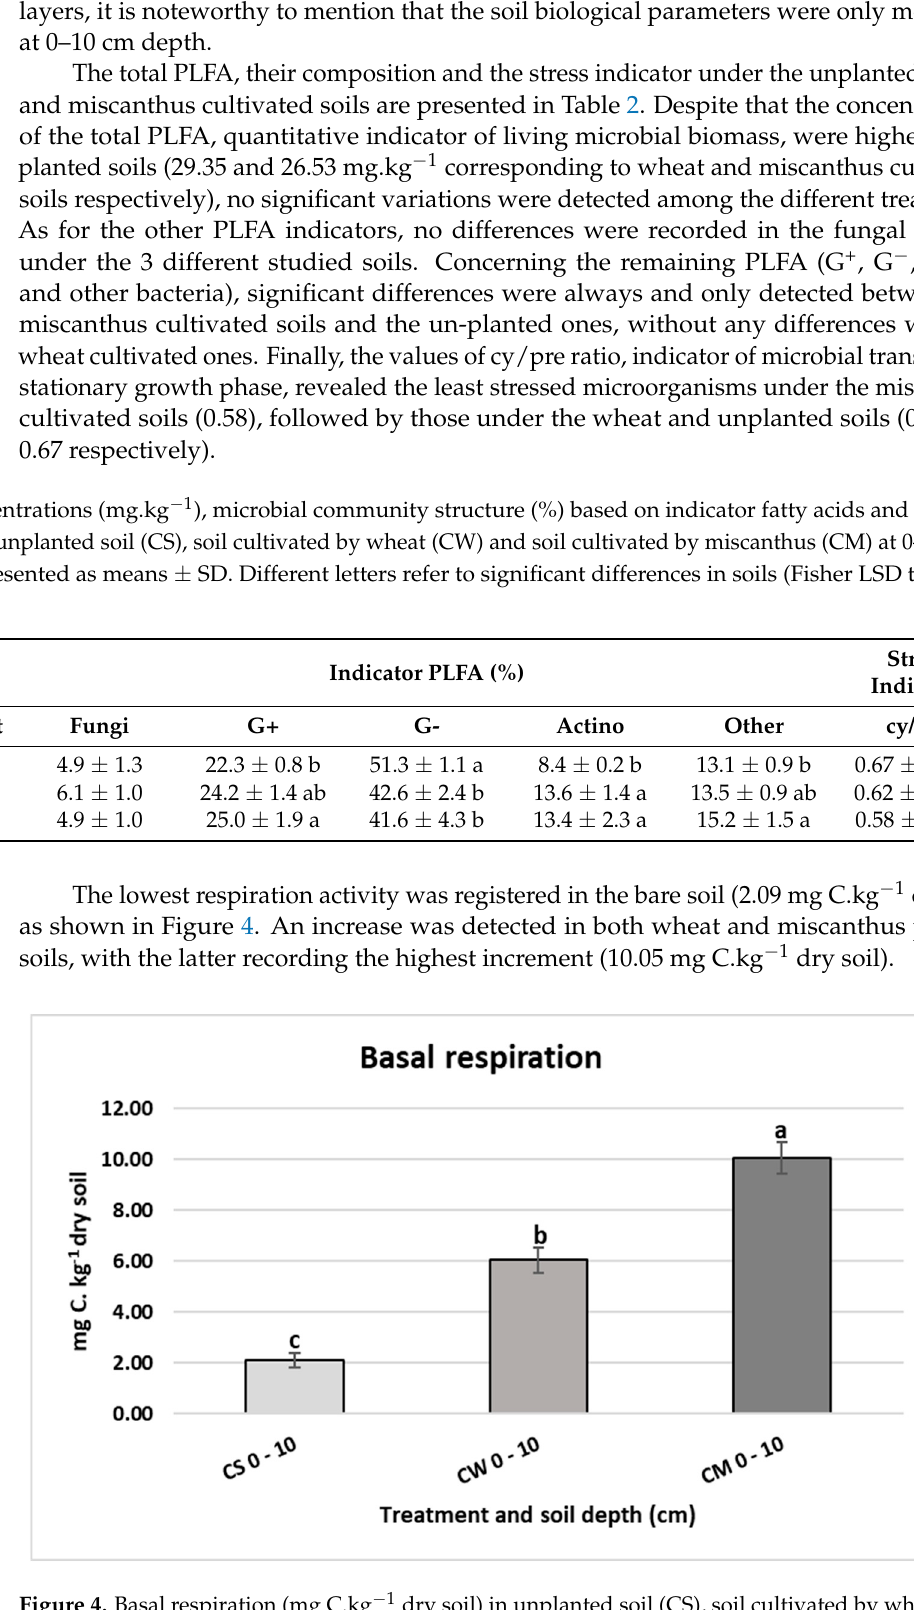
Figure 5. Fluorescein diacetate hydrolytic activity (mg fluo.g − 1 dry soil.h − 1 ) in unplanted soil (CS), soil cultivated by wheat (CW) and soil cultivated by miscanthus (CM) at 0–10 cm depths. Values are presented as means ± SD. Different letters refer to significant differences in soils (Fisher LSD test, n = 4, p ≤ 0.05). 3.3. δ 13. C Values and Plant Contribution to the Total SOC Stocks The δ 13 C values, indicator of photosynthesis ‐ based carbon input to the soil organic matter, (Figure 6) were influenced by the plant species. There was no significant difference among the unplanted and C 3 annual crop (wheat), where values ranged between − 26.90